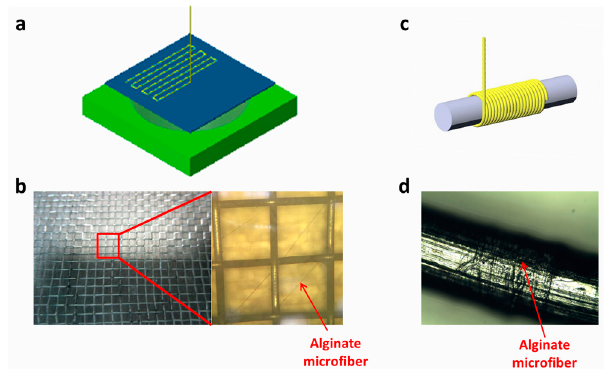
Figure 6. Microfiber collection and assembly. ( a ) Schematic of alginate microfiber patterning process. ( b ) Optical images of patterned alginate microfiber on a metal net substrate and the part in the red rectangle is enlarged on the right where alginate microfiber can be observed. ( c ) Schematic of alginate microfiber reeling process. ( d ) Optical image of reeled alginate microfiber on a wire.